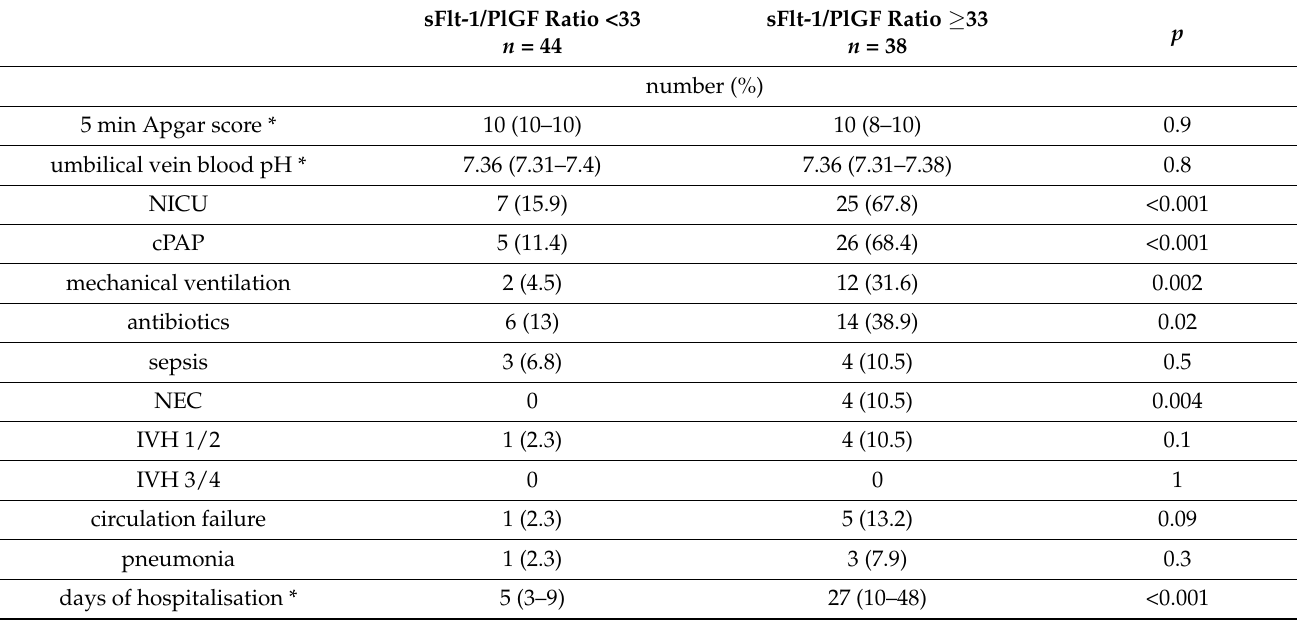
Table 2. Neonatal outcome in sFlt-1/PlGF ratio <33 and ≥ 33